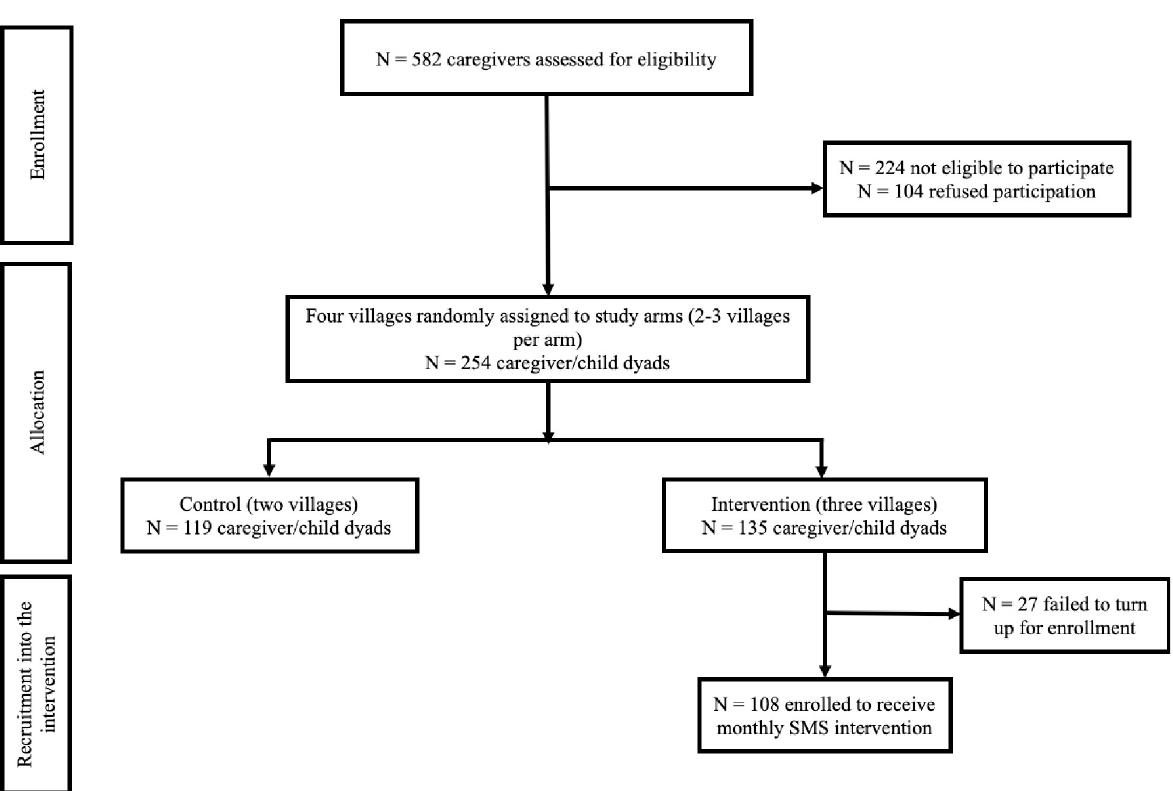
Fig 2. Flow diagram of the recruitment of participants into the main study (this paper focusses on the intervention arm only).